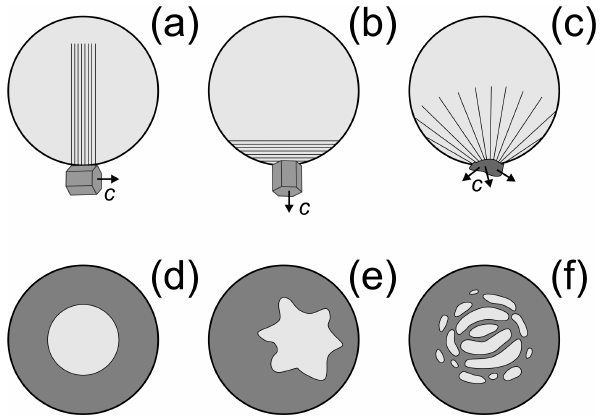
Figure 10. A conceptual diagram showing different possibilities of freezing of a supercooled droplet after nucleation by (a) monocrys- talline INP or ice crystal with c axis parallel to the droplet surface, (b) monocrystalline INP or ice crystal with c axis perpendicular to the droplet surface, and (c) polycrystalline INP or ice crystal. The visuals in (d–f) show various possible topologies of liquid zones formed during freezing: (d) idealized spherical liquid volume sym- metrically centered with the ice shell (frequently used in numerical simulations of droplet freezing), (e) non-symmetrical liquid volume displaced towards the ice shell wall, and (f) multiple disconnected liquid